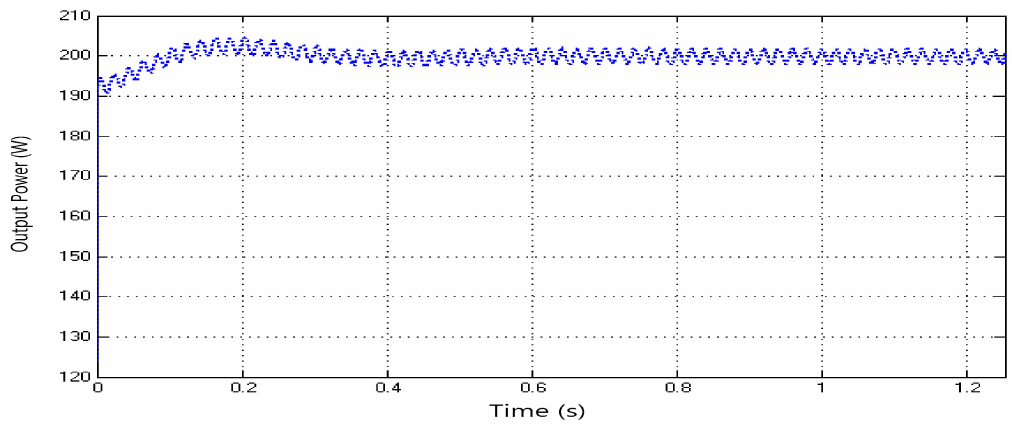
Figure 12. Output power graph of MATLAB / Simulink